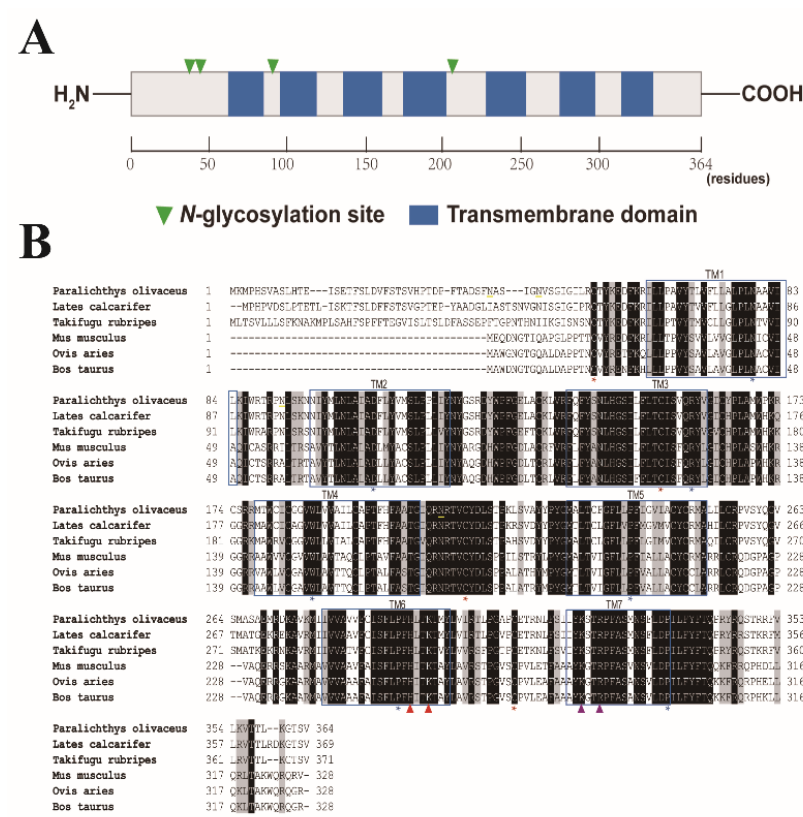
Figure 1. Schematic domain structure and sequence alignment of P2Y 6 receptor proteins. ( A ) The schematic domain structure of Japanese flounder P2Y 6 receptor protein. A scale bar of the amino acid residues is indicated at the bottom. ( B ) Alignment of the amino acid sequences of P2Y 6 receptor proteins from different species. The amino acid sequence of Japanese flounder Paralichthys olivaceus P2Y 6 receptor protein (XP_019943561.1) is compared with its orthologs from: Lates calcarifer (XP_018543417.1); Takifugu rubripes (XP_003977127.2); Mus musculus (NP_898991.1); Ovis aries (XP_014956561.1); and, Bos taurus (NP_001179224.1). The transmembrane domains (TM1-TM7) are boxed. The potential N -linked glycosylation sites in Japanese flounder P2Y 6 receptor protein are underlined in yellow. The four cysteine residues involved in disulfide bridges and the conserved residues among G-protein-coupled receptors of each transmembrane domain are denoted with red and blue stars, respectively. The conserved positive-charged residues responsible for nucleotide binding in the H-X-X-R/K motif and the Y-Q/K-X-X-R motif among P2Y 6 receptors are indicated by red and purple triangles, respectively. Identity is denoted by shaded white letters, and similarity is shown by shaded black letters.